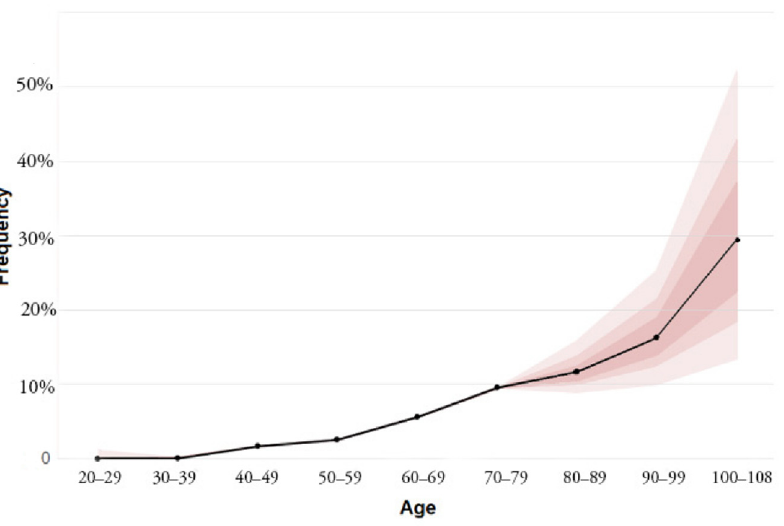
Figure 2. Increase in the frequency of mutations in genes implicated in hematologic cancers with age. Colored bands, in increasing lighter shades, represent the 50th, 75th, and 95th percentiles (modified from [11]).